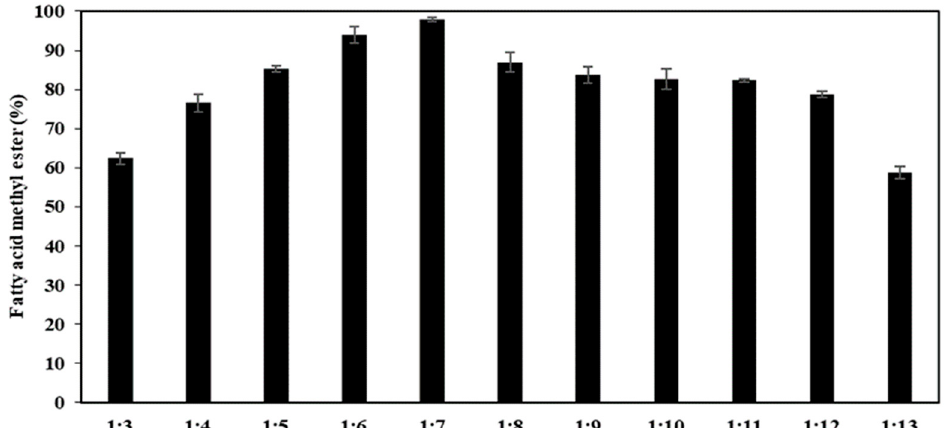
Figure 8. Effects of the ratio of the molar ratio on FAME production in the transesterification reaction using a 2 mL microcentrifuge tube catalyzed by M. spicifer SPB2 cells from a 5-L stirred-tank bioreactor. This was in the presence of palm oil and methanol, as substrates with 5 × 10 9 of yeast cells per gram substrate, incubated at 30 ± 2 °C in a vigorous shaker for 72 h.